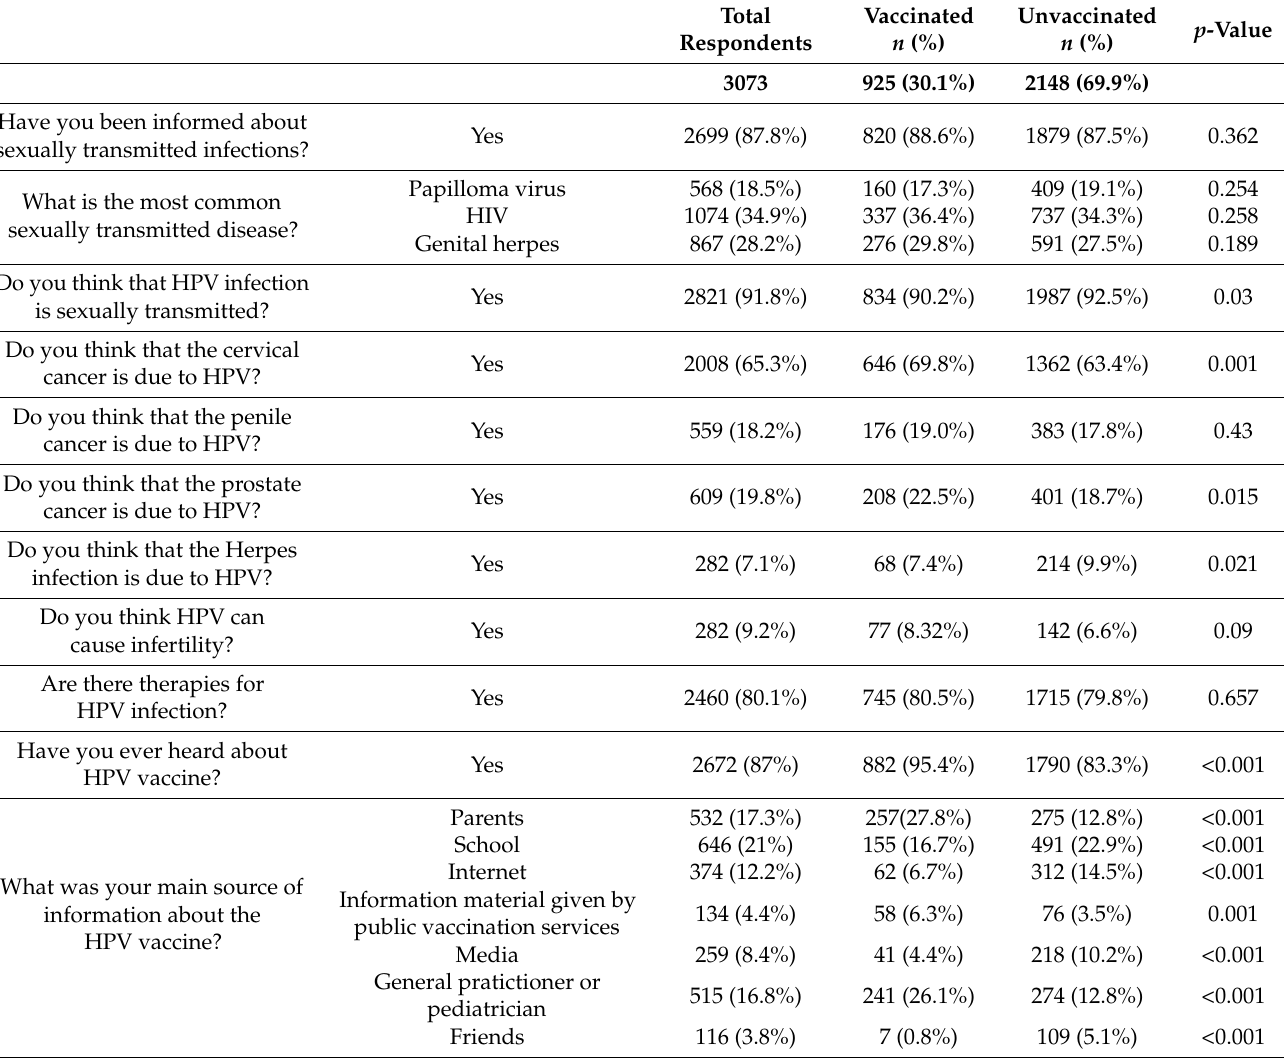
Table 2. HPV infection and HPV vaccine knowledge, and differences between fully or not vaccinated for